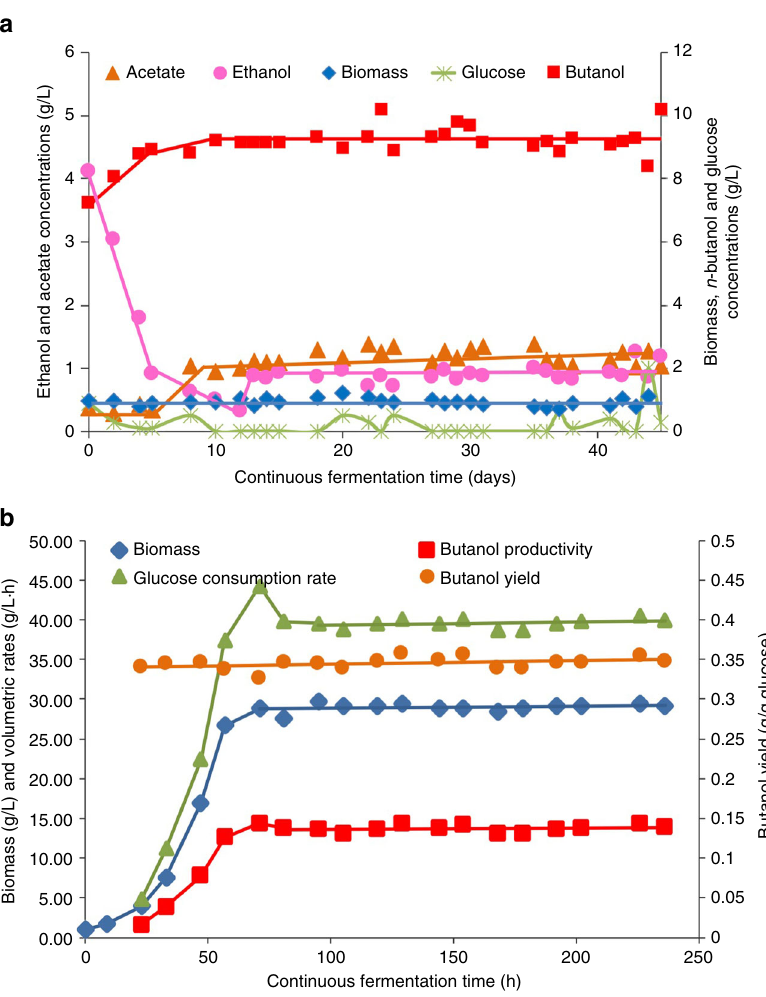
Fig. 3 Continuous cultures of C. acetobutylicum CAB1060. a In phosphate-limited chemostat culture at pH 5, b in phosphate-limited high cell density culture at pH 5 with in situ extraction of the alcohols ( n -butanol + ethanol) by distillation under low pressure. The arrow indicate the start of the cell bleeding. For both continuous cultures, the initial batch phase is not